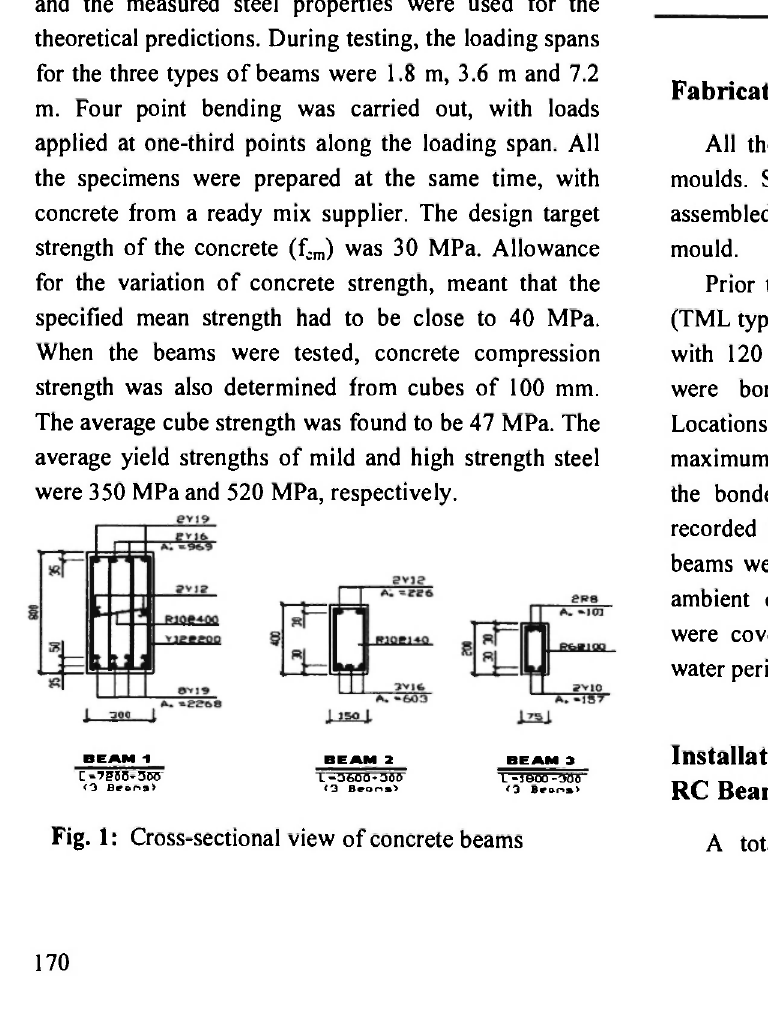
Fig. I: Cross-sectional view of concrete